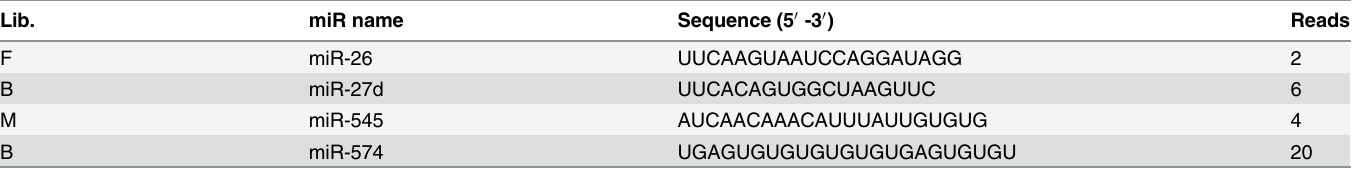
Table 3. Conserved miRNA candidates against the miRBase database.